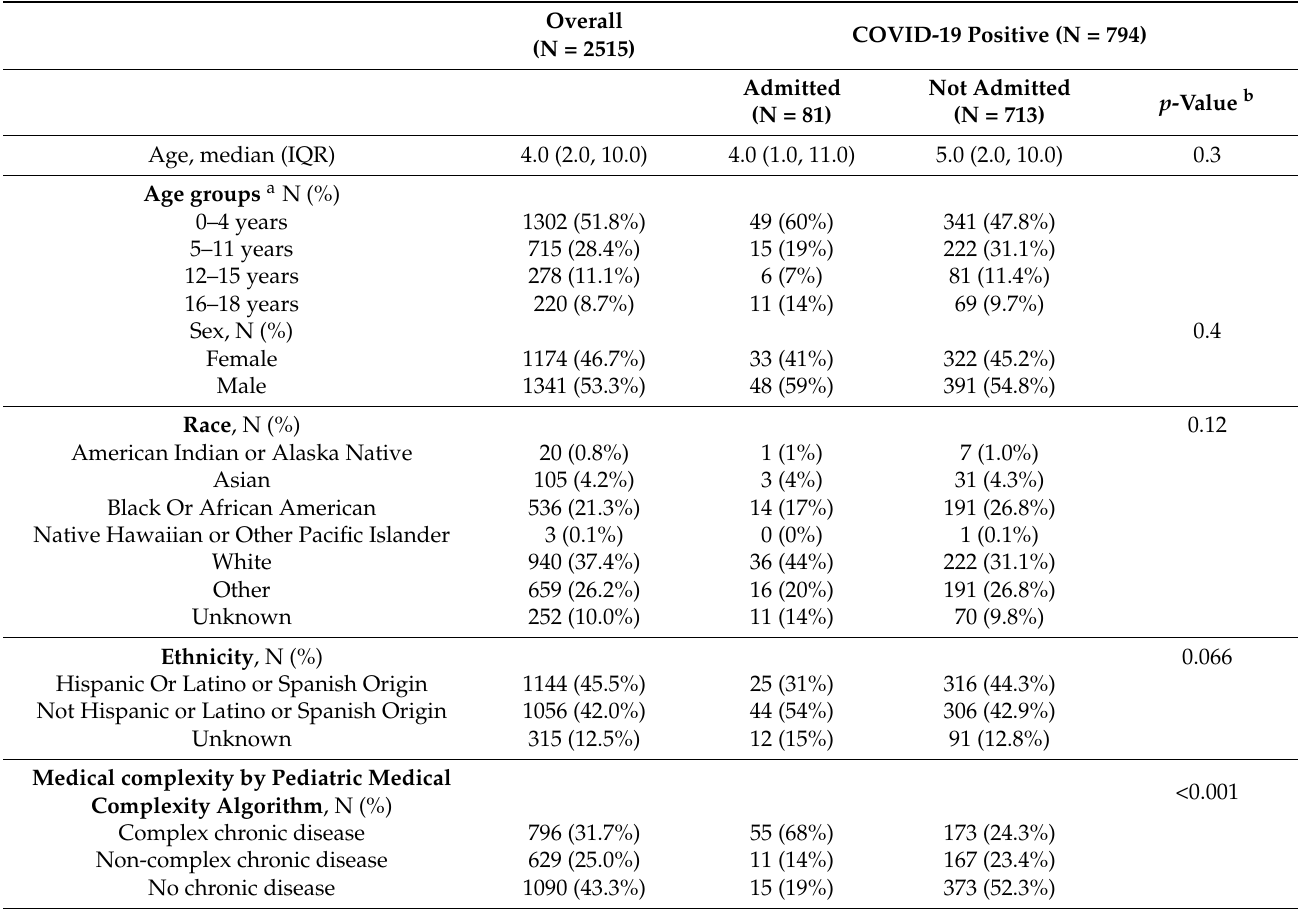
Table 1. Demographic Characteristics of Patients Aged ≤ 18 years Presenting to Emergency